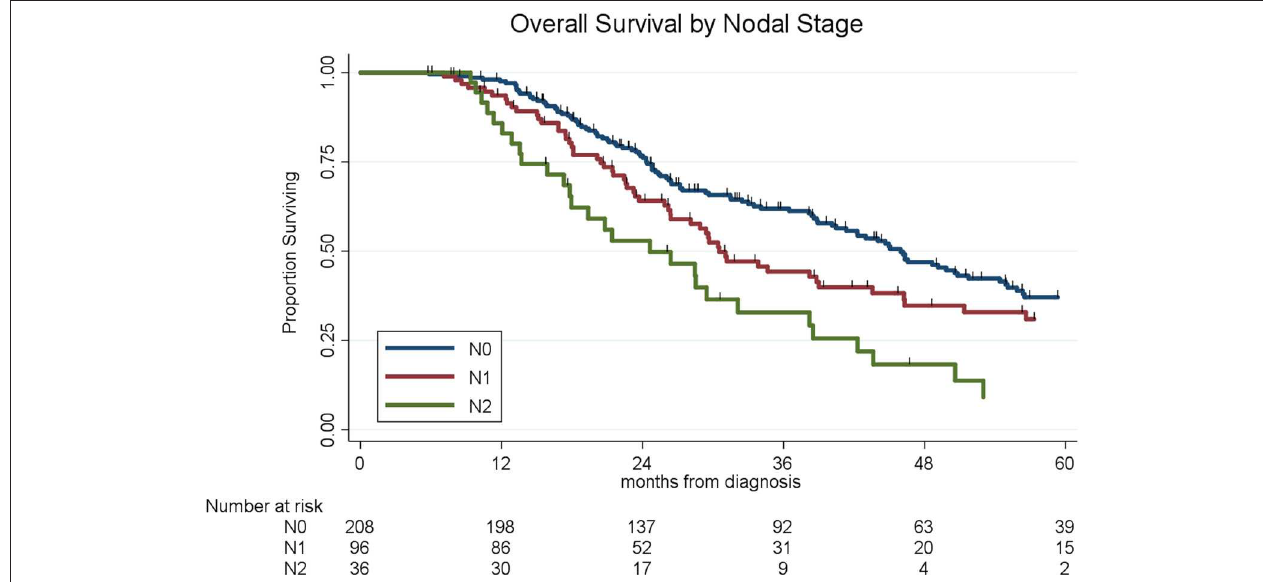
FIGURE 3 | Overall survival by lymph node status.